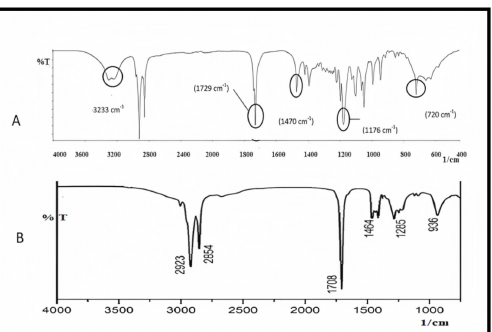
Figure 5. FTIR spectra of ( A ) GMS and ( B ) oleic acid, plot of %Transmittance vs. 1/cm.